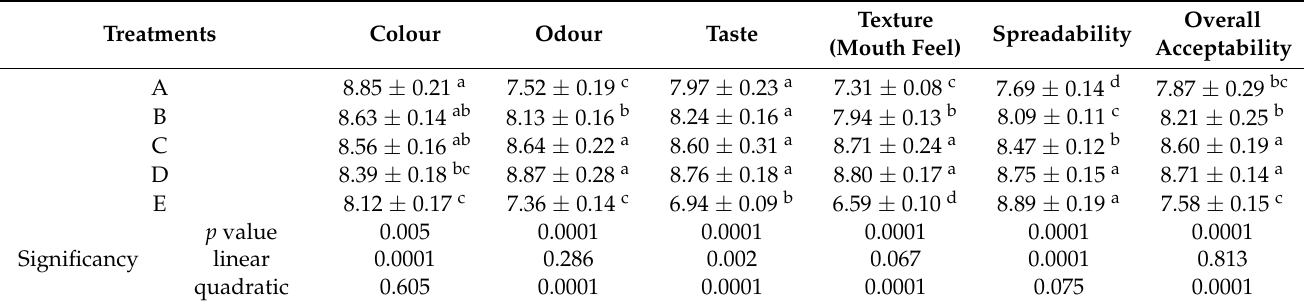
Table 5. Sensory properties of date jam prepared with different amounts of powdered date